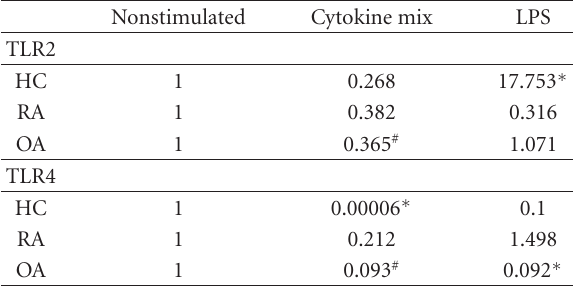
mRNA in nonstimulated as well as in LPS or cytokine-mix stimulated cells was similar in patients with RA and OA, although in both groups, it was significantly lower than in cells from